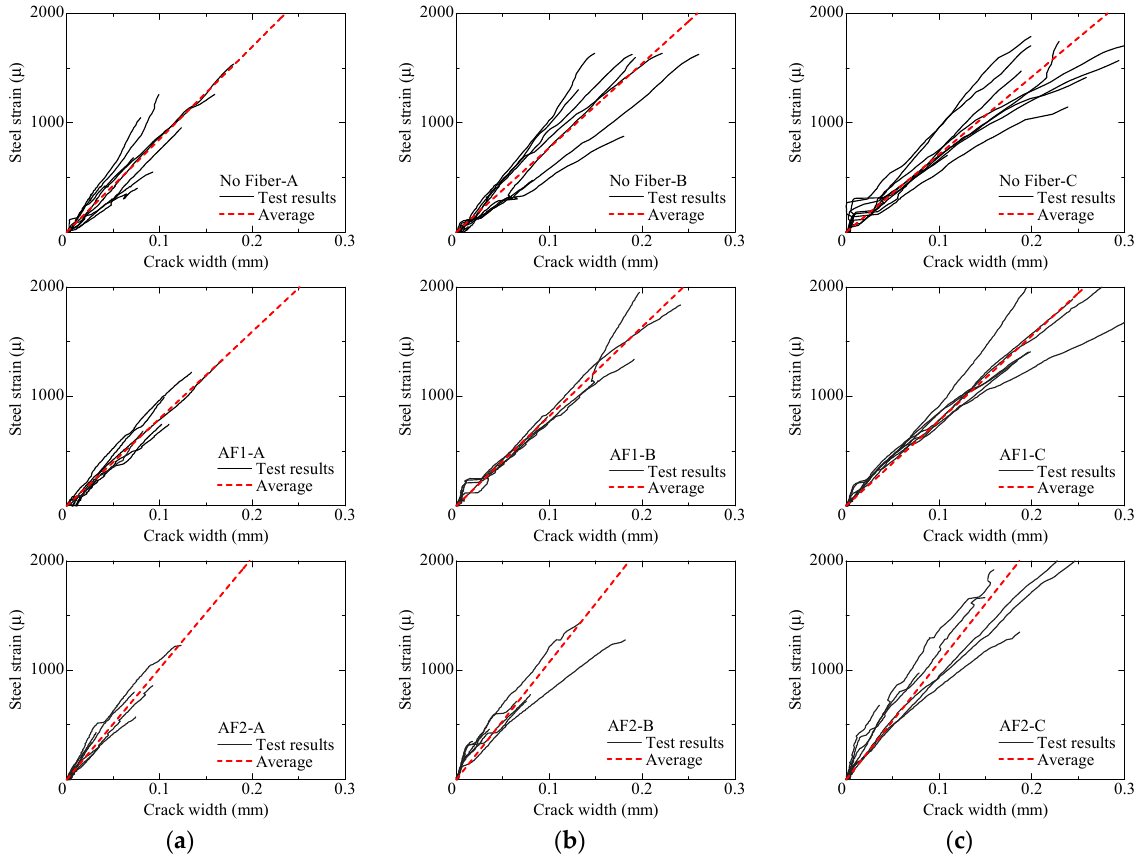
Figure 13. Steel strain–crack width relationship: ( a ) A series; ( b ) B series; ( c ) C series. The slope of the average lines is larger in AF2 specimens compared with AF1